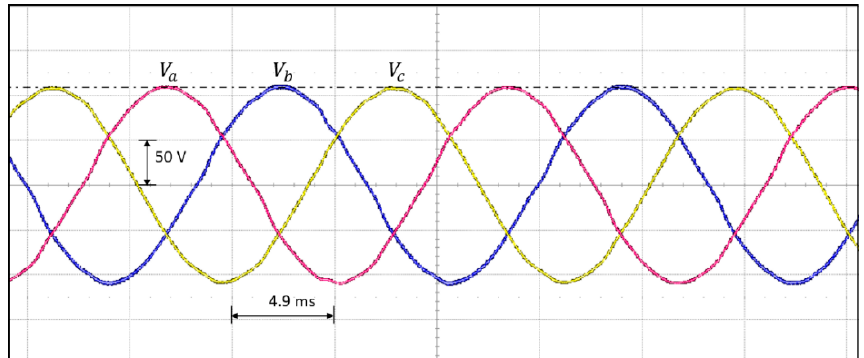
Figure 11. The steady state response of the three-phase output voltages with MPC-DOB under the